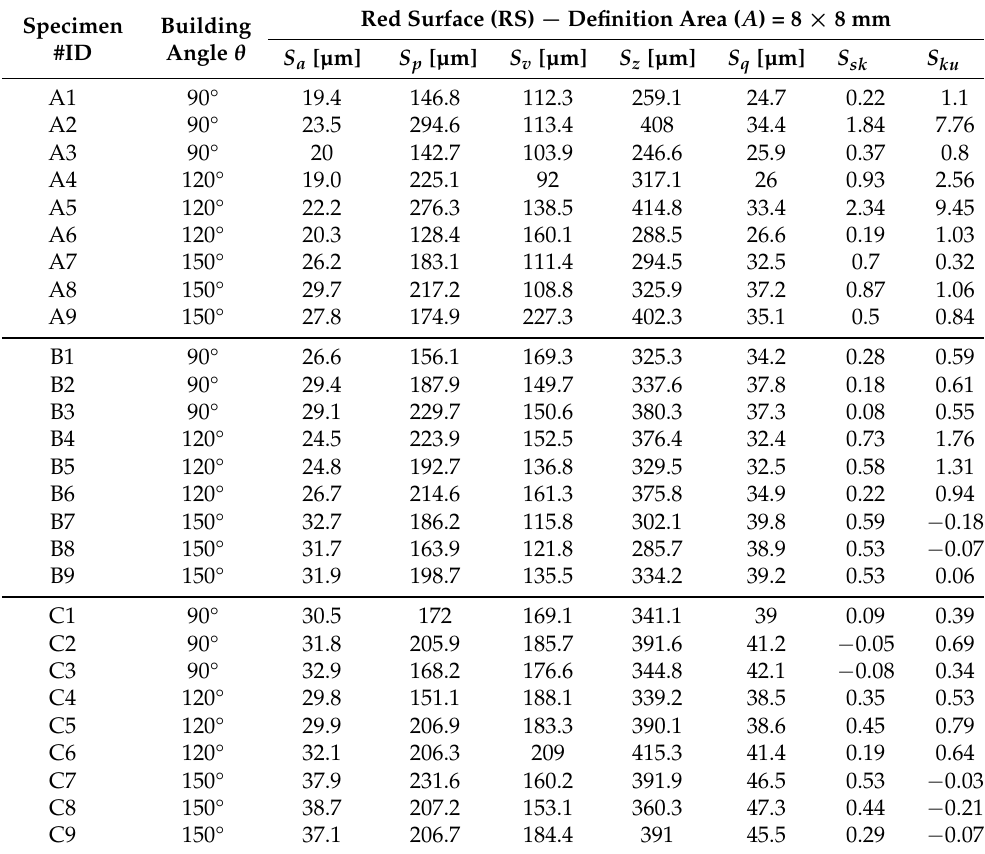
Table 8. Surface texture parameters results: RS with a definition area ( A ) = 8 × 8 mm.